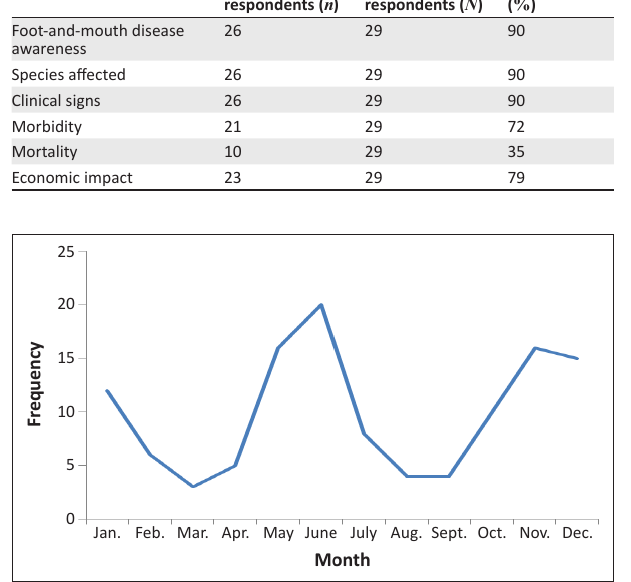
FIGURE 1: Temporal trends of foot-and-mouth disease outbreaks and its respective frequencies as scored by the respondents.